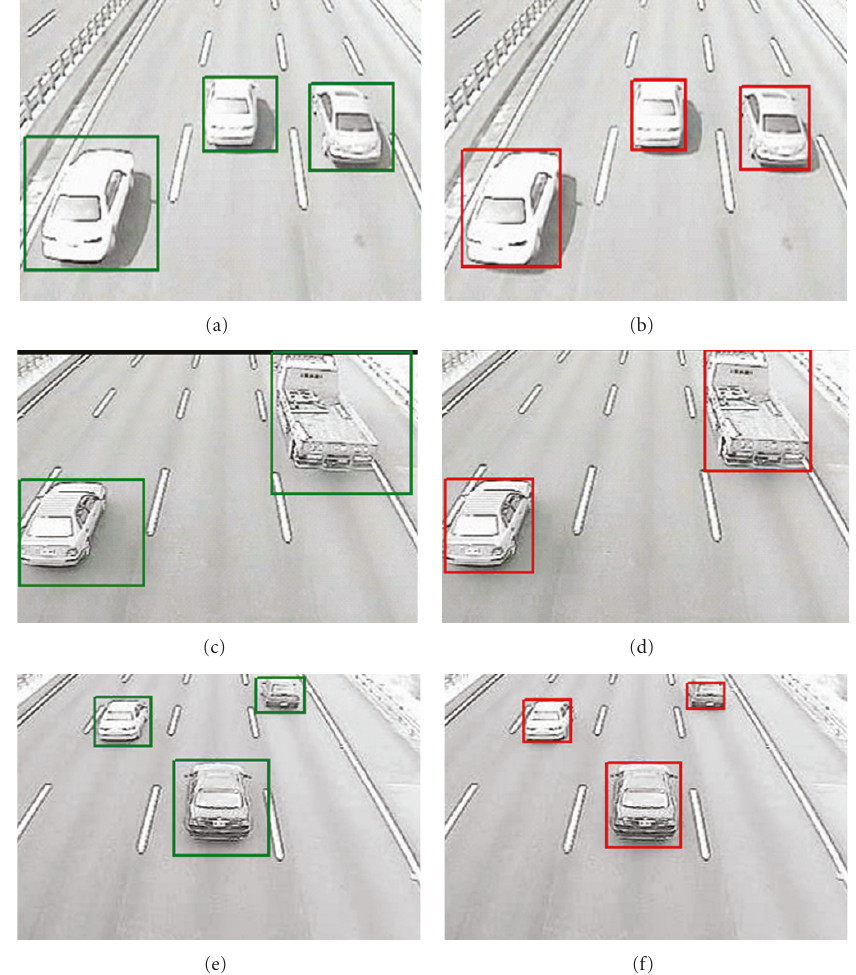
Figure 27: Experimental results for di ff erent kinds of shadows.